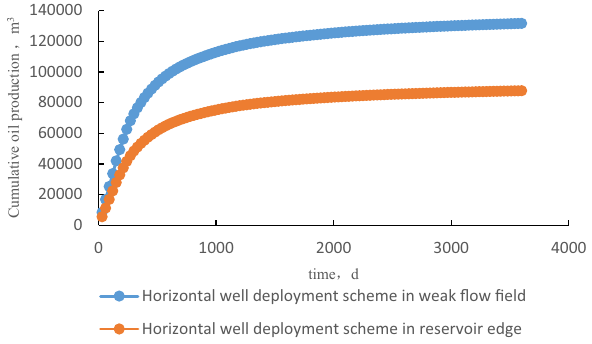
Fig. 12 Comparison diagram of cumulative oil output in horizontal well